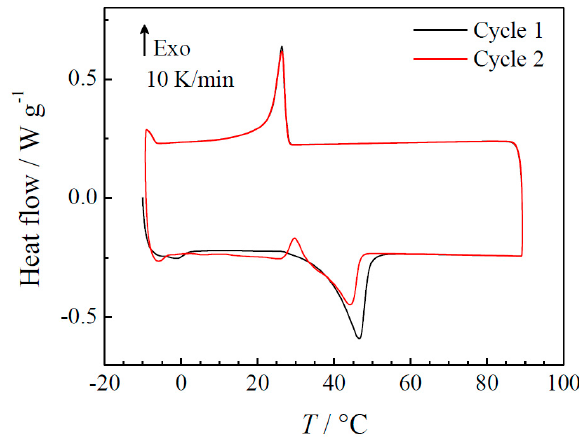
Figure 2. DSC thermograms showing heating and cooling curves of vegetable shortening sample measured at 10 K/min for two melt-freeze cycles.